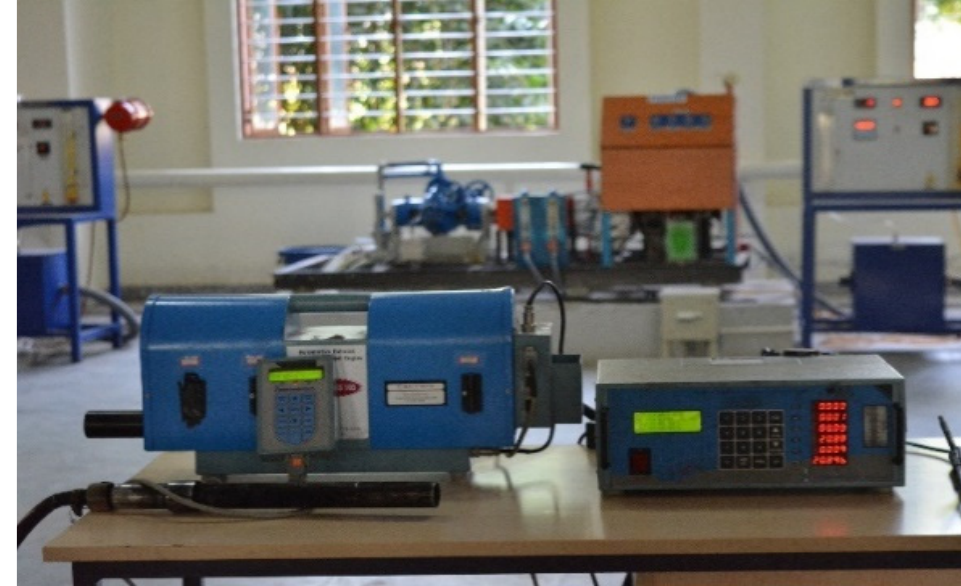
Figure 14. Digital image Indus scientific exhaust gas analyzer.